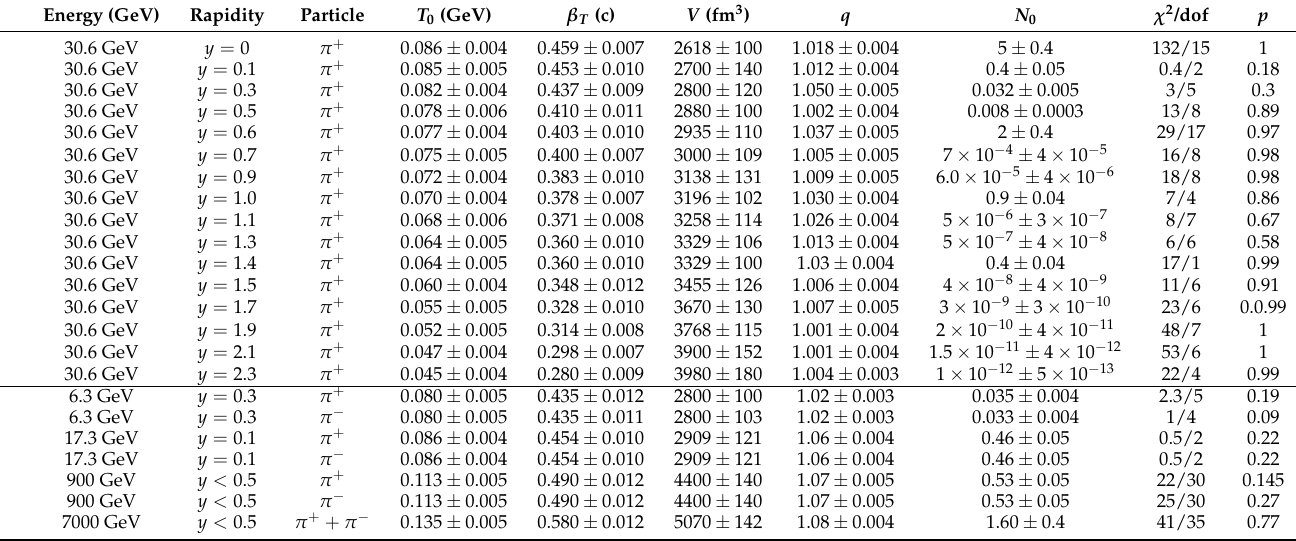
Table 1. ( n 0 = 1) Values of free parameters T 0 and β T , V and q, normalization constant ( N 0 ), χ 2 and degree of freedom (dof) corresponding to the curves in Figure 1. The p -values of χ 2 -statistics are also presented, which were calculated in R-software by pchisq ( χ 2 values, degree of freedom).